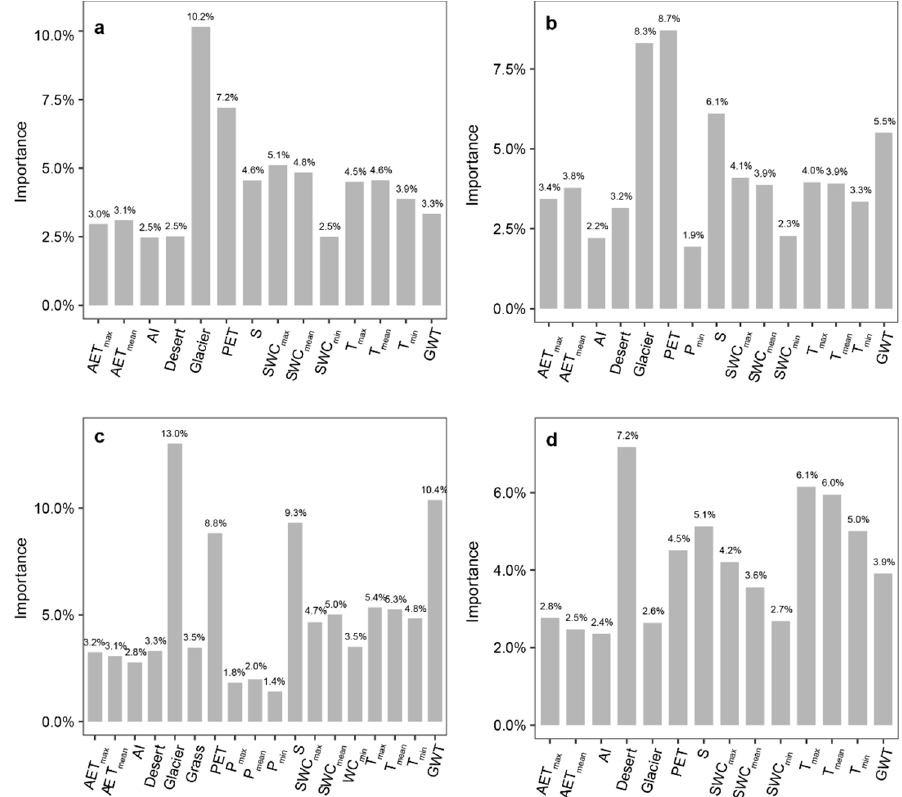
Figure 7. Relative contributions of basin factors to the differences in structural parameters for the 60 sub-basins in the Tarim River basin: ( a ) bifurcation ratio (R B ); ( b ) fractal dimension (F D ); ( c ) drainage density (D D ); ( d ) mean length of the rivers at stream-order 5 (L 5 ). The bar chart shows the variable importance, that is, the proportion of explained variability calculated via multiple regression modeling and variance decomposition analysis.